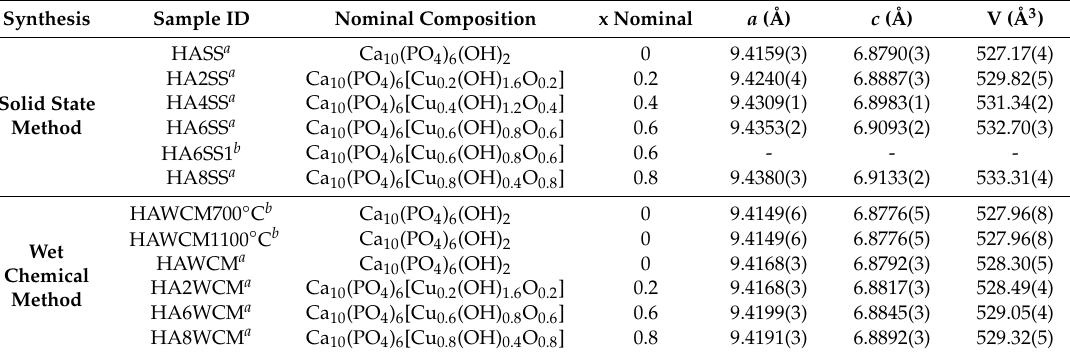
Table 1. Sample ID, nominal compositions and lattice parameters of cupriferous